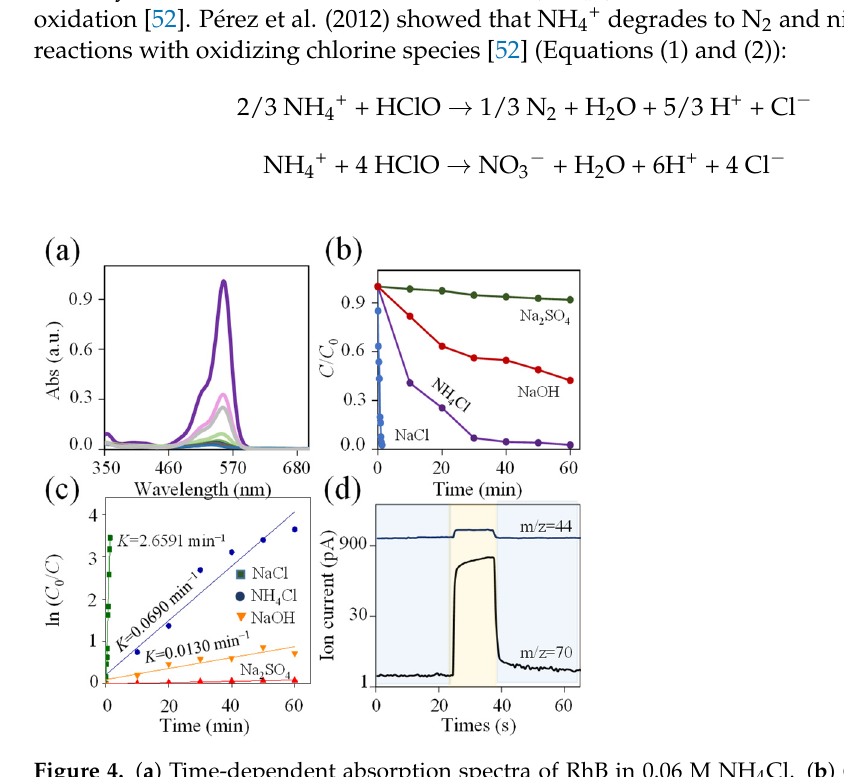
Figure 4. ( a ) Time-dependent absorption spectra of RhB in 0.06 M NH 4 Cl. ( b ) C / C 0 vs. time in differ- ent electrolytes at 2.0 V vs. RHE. ( c ) Pseudo-first-order degradation kinetics of RhB in different elec- trolytes at 2.0 V vs. RHE. ( d ) Ionic current vs. time detected using mass